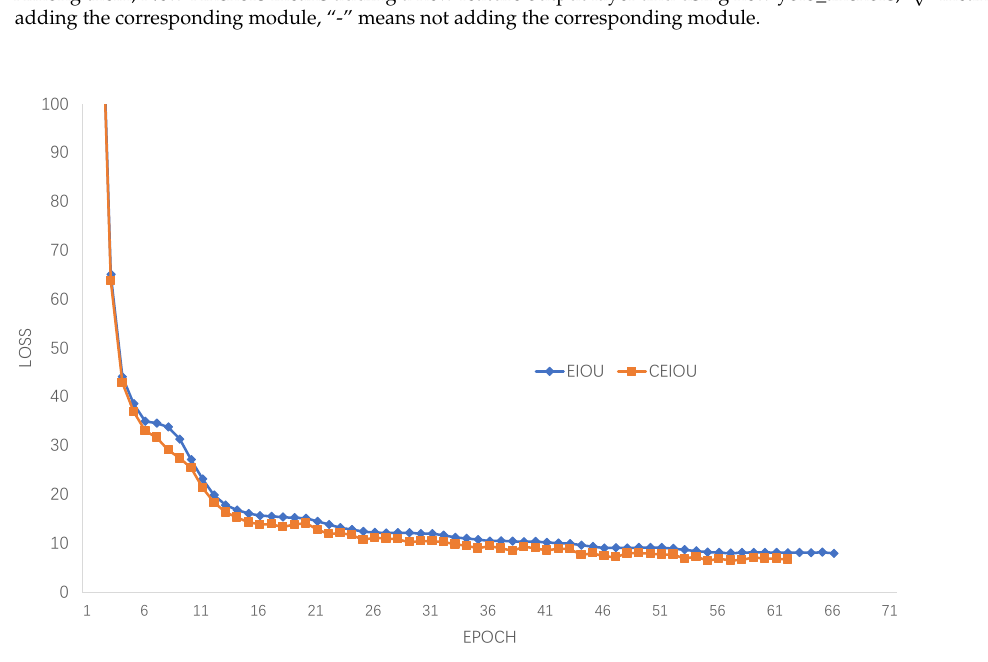
Figure 9. Comparison of CEIOU and EIOU in training.